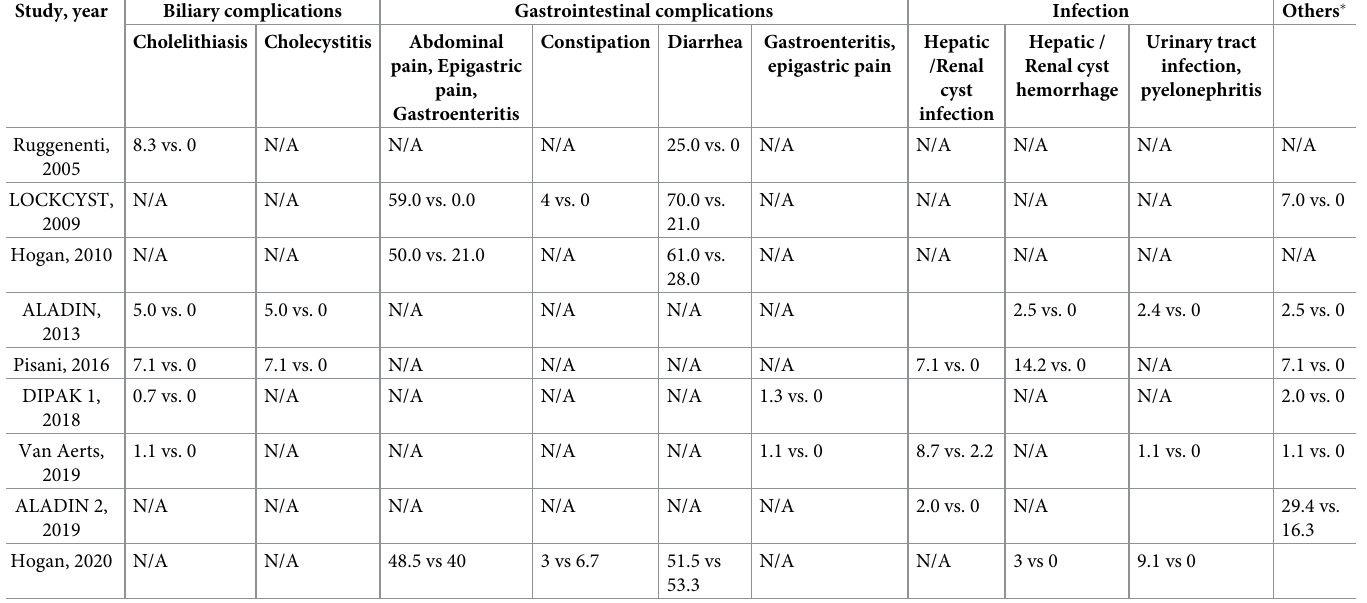
Table 3. Severe adverse events; % in somatostatin group vs. % in control